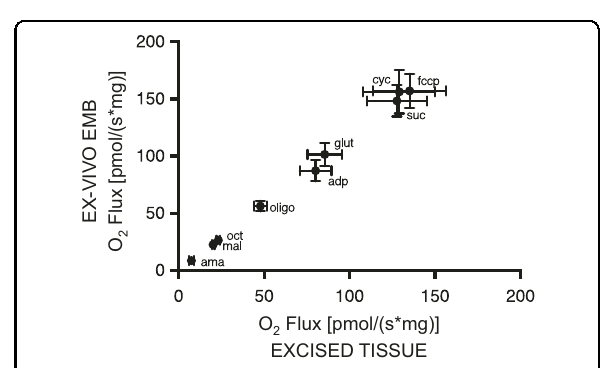
Fig. 3 Mitochondrial state III respiration of biopsies endoscopically harvested using a bioptome revealed the same results compared to standard excised myocardial tissue specimens from left ventricular apex tissue samples obtained during left ventricular assist device surgery. Mitochondrial respiration was measured after addition of octanoyl-carnitine and the citrate cycle-derived substrates glutamate and succinate in an oxygraph. ama antimycin A, mal malate, oct octanoyl-carnitine, oligo oligomycin, adp adenosine diphosphate, glu glutamate, suc succinate, cyc cytochrome c, fccp carbonyl cyanide- 4 -(tri fl uoromethoxy) phenylhydrazone. Pearson correlation; data are the means ± SEM ( n